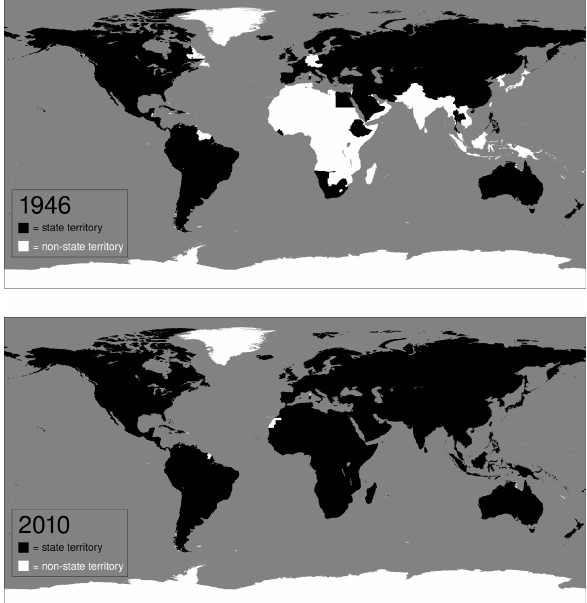
Figure 2: The spread of Westphalia, produced as part of a separate GIS project. Pickering, 2012.